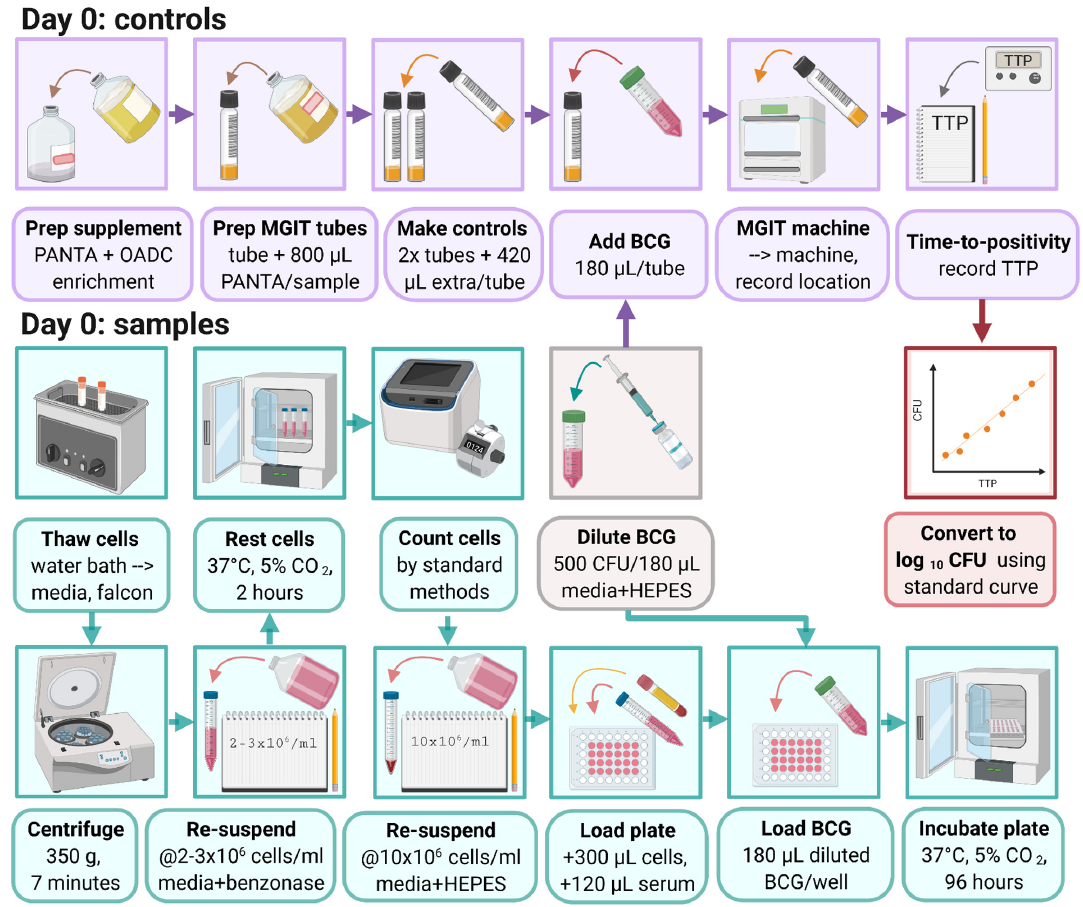
Figure 3. Day 0 MGIA set-up (created with